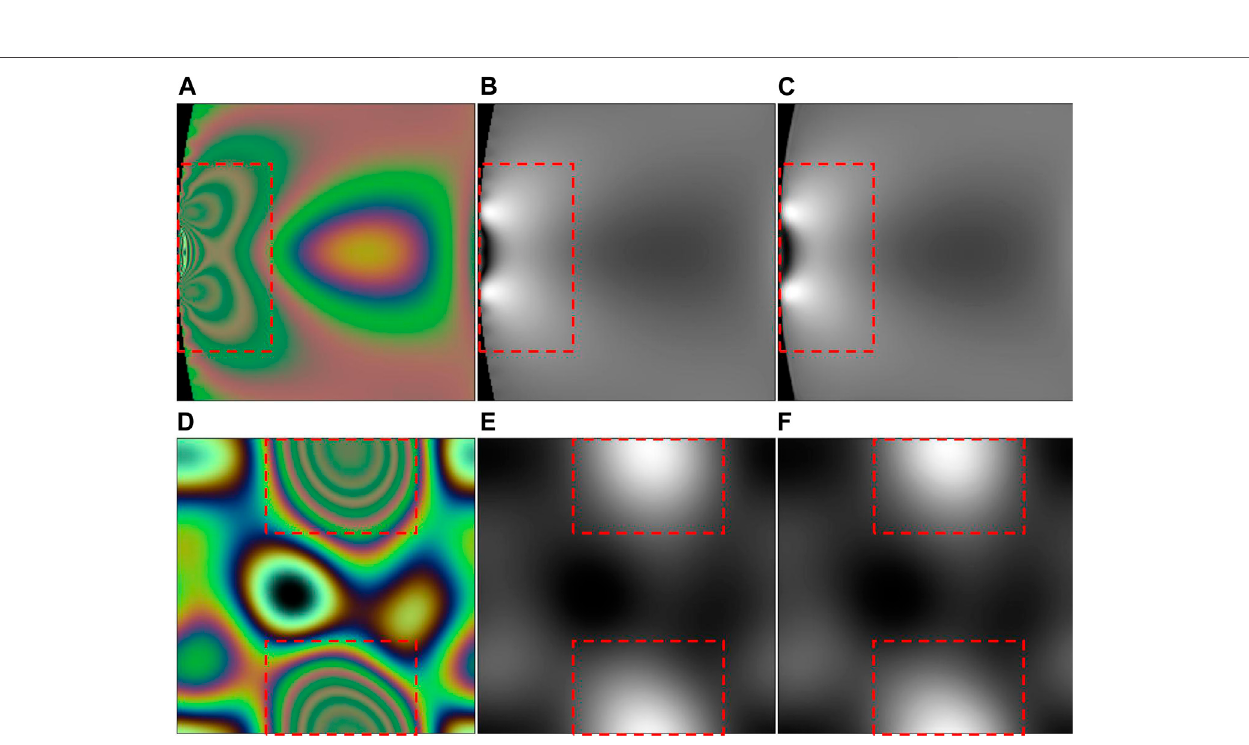
FIGURE 8 | Stress concentration zones. Photoelastic fringes (A,D) and corresponding stress maps (B,E) are selected from the test set (Briñez-de León et al., 2020e). (C,F) are stress maps recovered by our proposed method. The region inside the red box is the stress concentration zone.